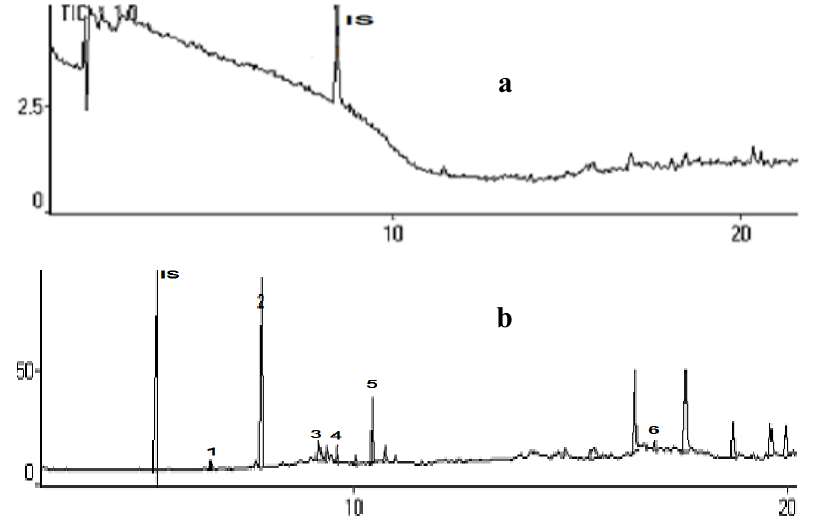
Figure 2. Total ion chromatogram of blood plasma sample after inhalation of ki lemo bark oils. ( a ). chromatogram of the sample after ½ h inhalation; ( b ). chromatogram of the sample after 1 h inhalation; ( c ). chromatogram of the sample after 2 h inhalation. IS: Internal standard (1,4-dichlorobenzene). Identity of peaks is shown in Table 5.